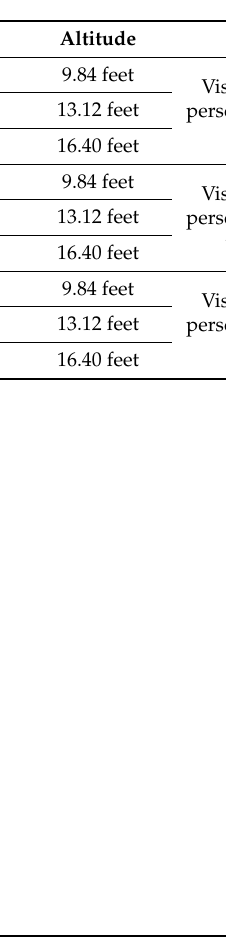
Table 4. Test cases with people and vehicles.